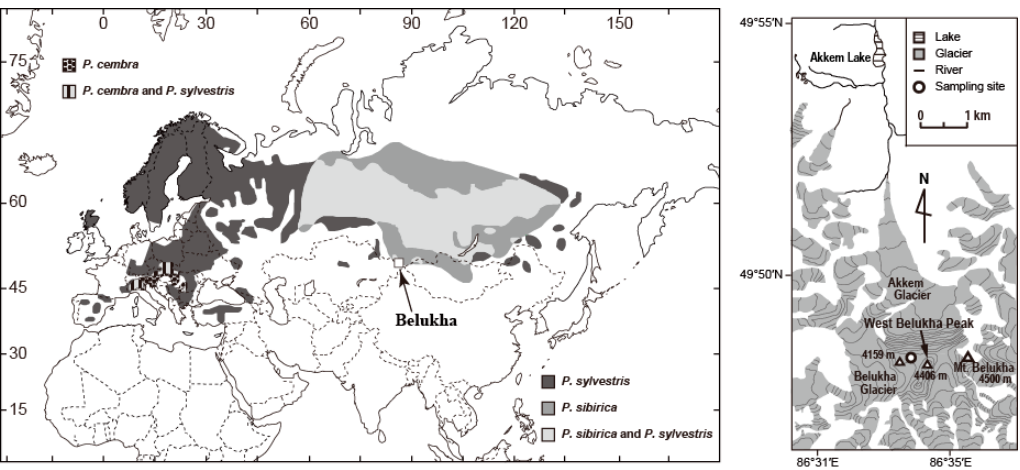
Figure 1. Location of the Belukha glacier in Russia’s Altai Republic, and distributions of extant P. cembra and two Pinus species ( P. sibirica and P. sylvestris ) found in the region surrounding the glacier.